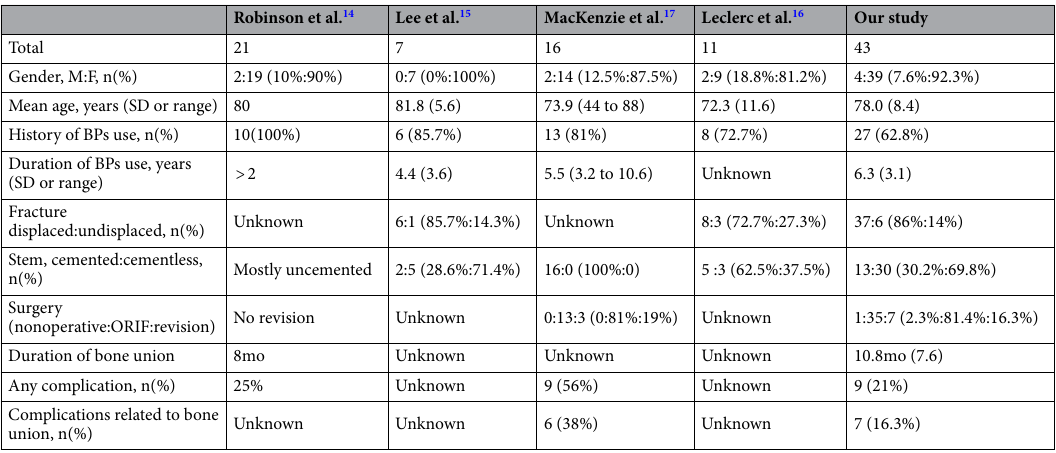
Table 4. Summary of the literature on atypical periprosthetic femoral fracture (APFF).